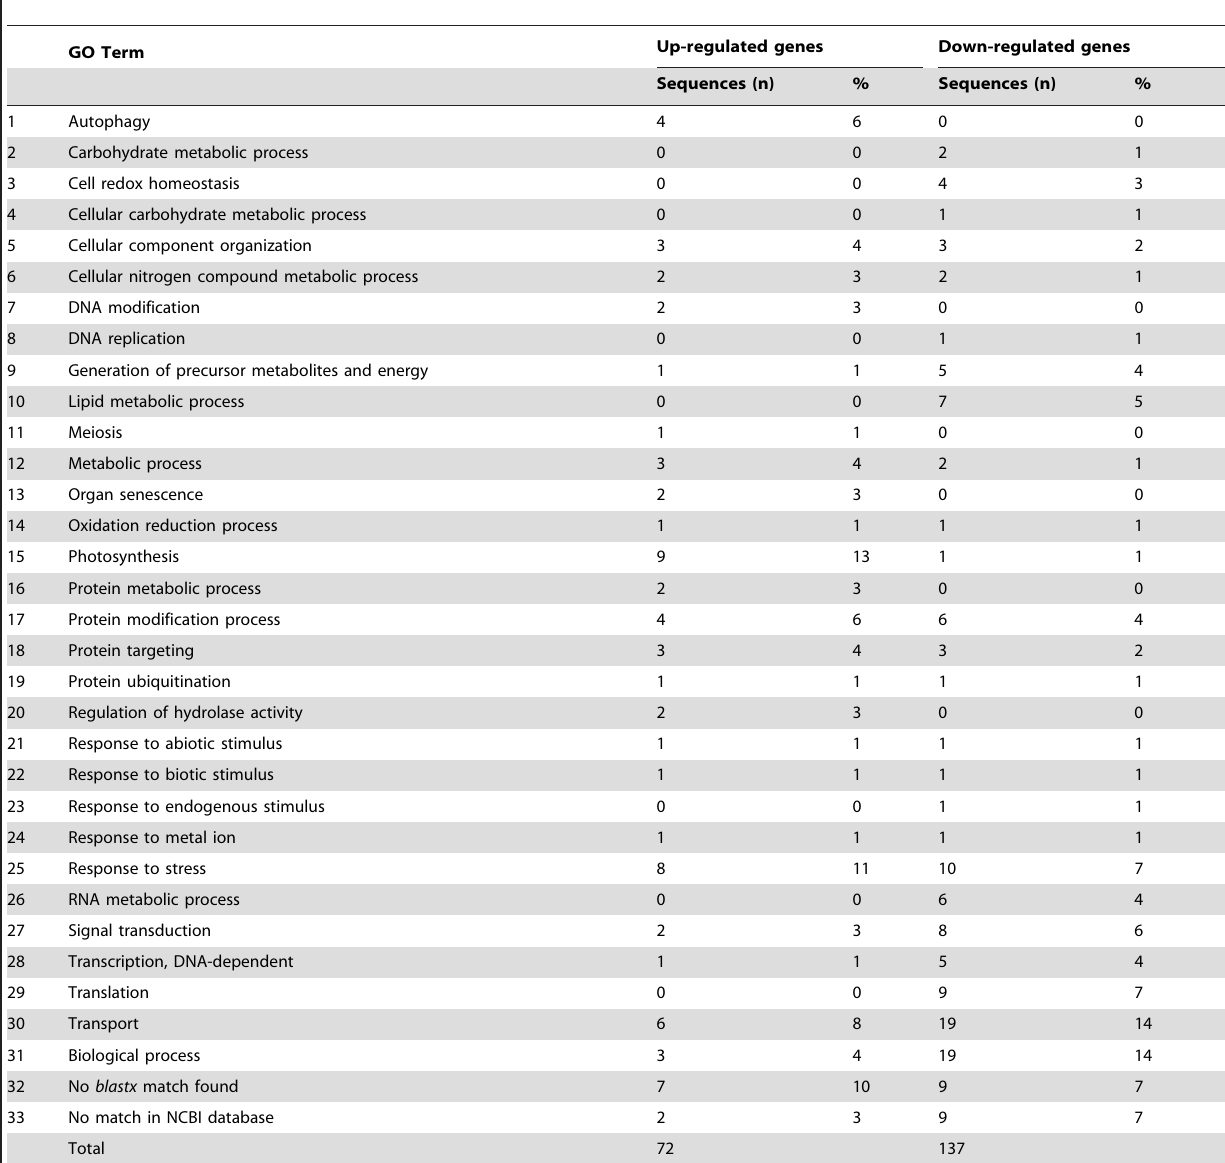
Table 3. Gene ontology (GO) categorization of the 209 differentially expressed plant genes found by SOLiD-SAGE.